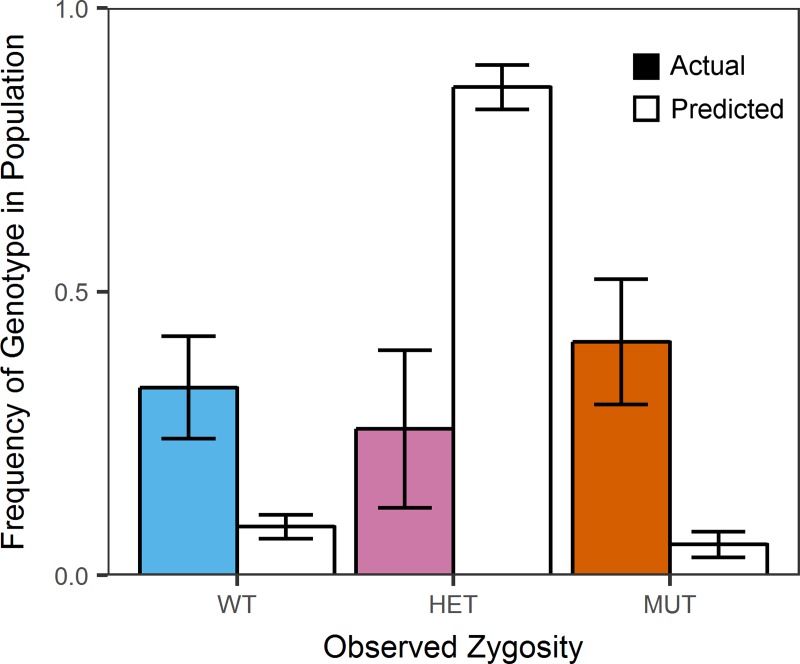
Mean actual observed zygosity of OCI-AML3 cells compared to zygosity predicted from variant allele frequency.Colored bars represent the mean zygosity frequency measured in single cells (847 single-cell measurements total). White bars with black outline represent the predicted mean zygosity frequency we expect our method to report for a sample for which all single cells are heterozygous. Actual genotype data is for N = 12 arrays of OCI-AML3 cells. Predicted genotype data is from measurements of single plasmids with one copy of each wild-type and mutant allele. Predicted genotype data are for N = 6 arrays of these heterozygous plasmids. In each case, genotype frequencies were quantified in each array; reported means were calculated between arrays. Error bars represent standard deviations of these measurements.